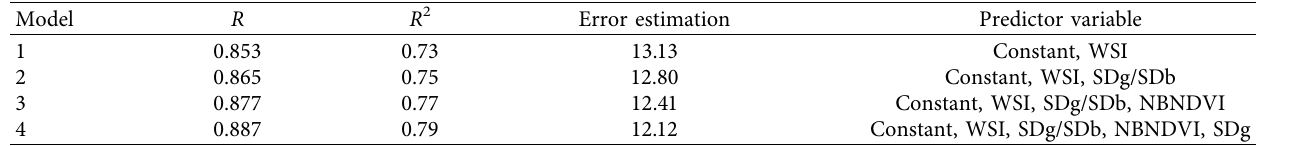
Table 4: Multiple stepwise regression model implemented in